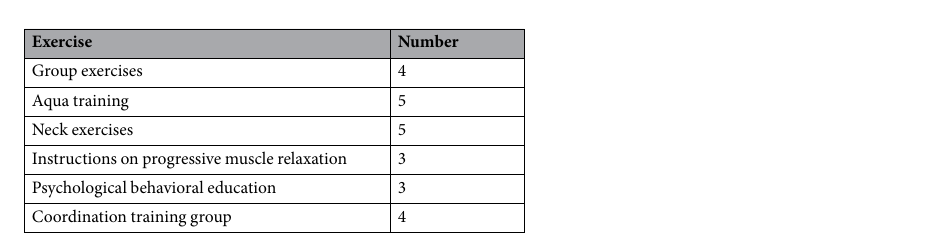
Table 2. Example of a 10-day schedule of physiotherapy and sports therapy as part of inpatient